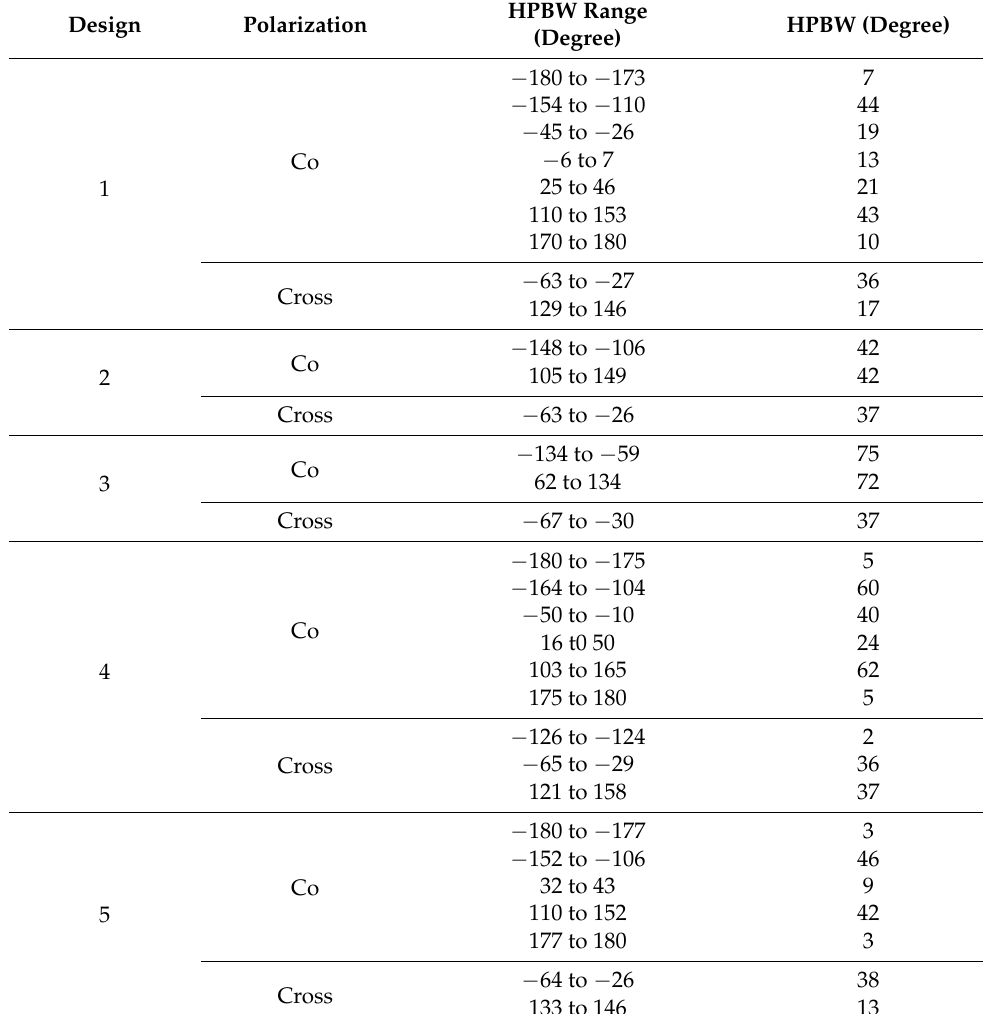
Table 4. The comparative analysis of the calculated half-power beamwidth (HPBW) for the antennas at both port excitation conditions P 1 = 1 and P 2 =